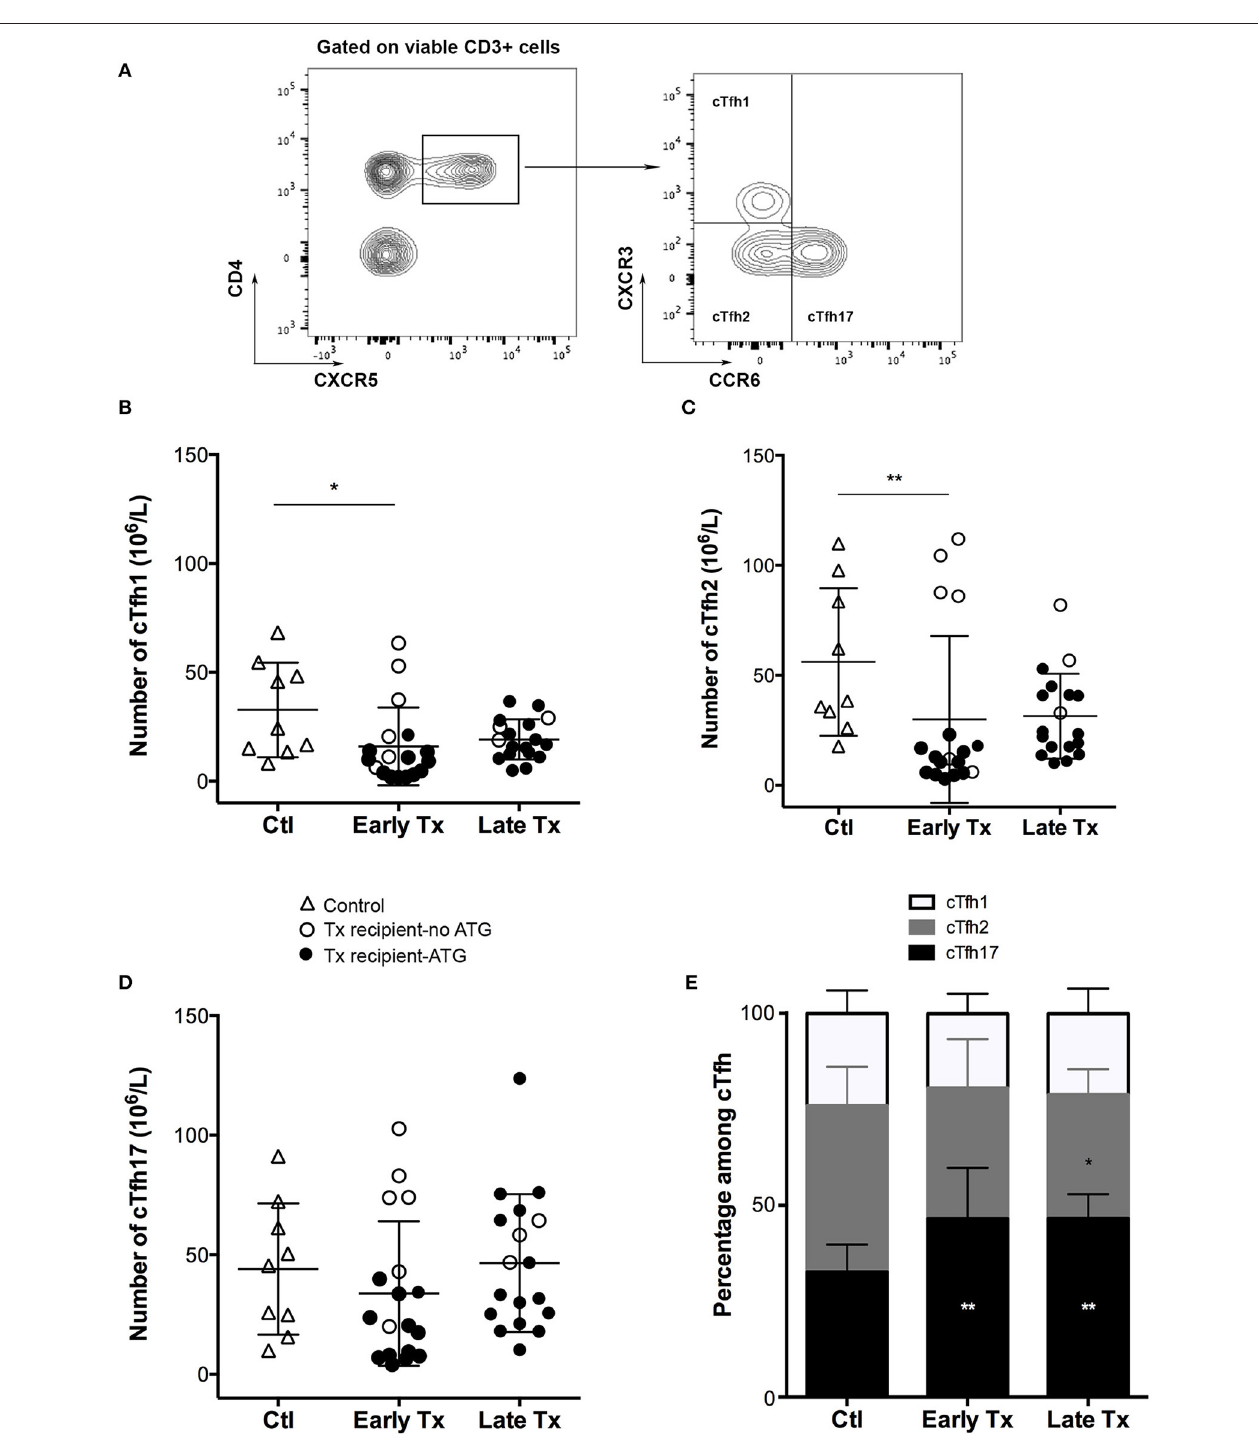
FIGURE 1 | Comparison of the static profile of cTfh of controls and transplants patients. (A) PBMC of patients were collected just before vaccination. Flow cytometry gating strategy used to identify the three subsets of circulating T follicular helper (cTfh). (B–D) The number cTfh of each of the 3 subsets (B : cTfh1; C : Tfh2; D : cTfh17) was enumerated among the PBMCs of healthy volunteers ( n = 9; controls, Ctl; open triangles), and transplant patients ( n = 36, circles). The nature of induction immunosuppressive therapy received by transplant patient is indicated. Transplant patients were distributed into two groups according to the time elapsed since transplantation: (i) 6–12 months: early post-transplantation (Early Tx; n = 18), and (ii) > 12–72 months: late post-transplantation (Late Tx; n = 18). Each symbol represents a patient, mean ± SD is indicated. * p < 0.05; ** p < 0.01; ANOVA, Dunn’s multiple comparisons test. (E) The proportion (mean ± SD) of each of the three subsets of cTfh is compared between the three groups. * p < 0.05; ** p < 0.01; Mann-Whitney test.